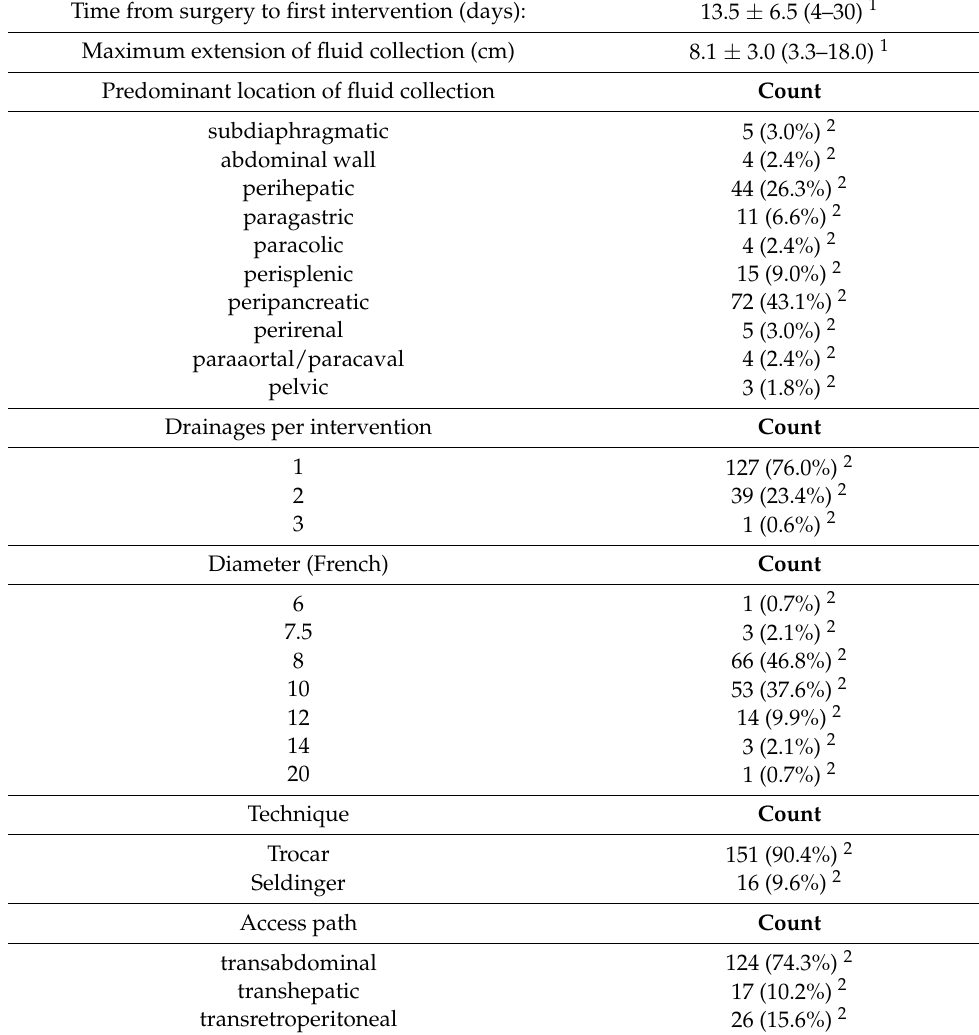
Table 2. Information on the affected anatomical regions, drainages, and techniques in the 167 CTD